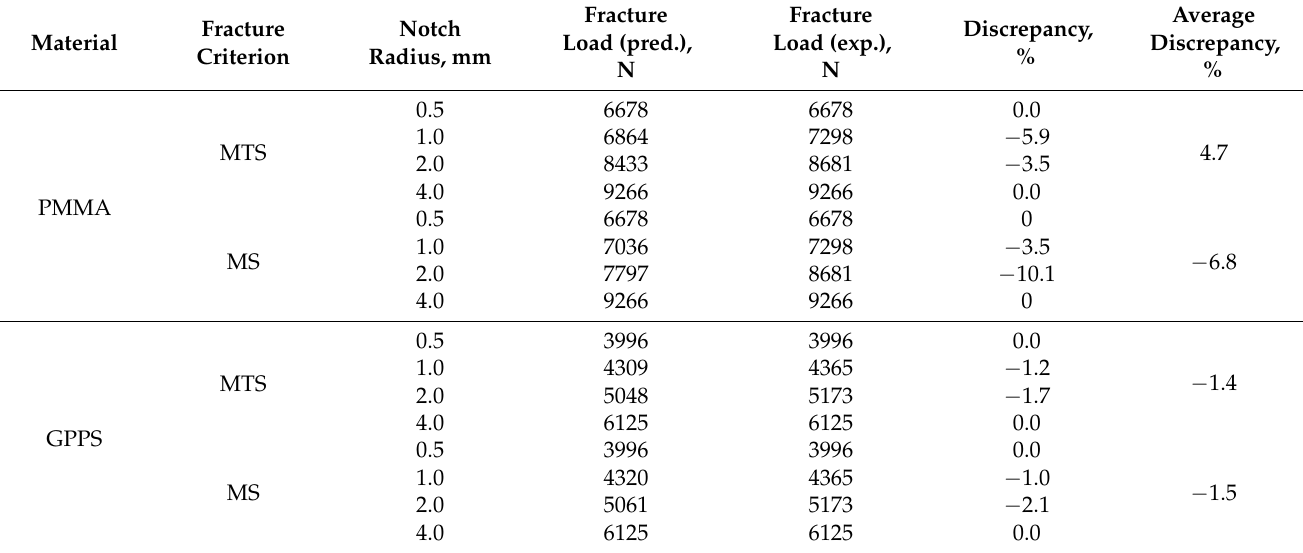
Table 4. Comparison between experimental (exp.) fracture loads and fracture prediction (pred.) derived from MTS and MS criteria (experimental calibration of critical parameters).